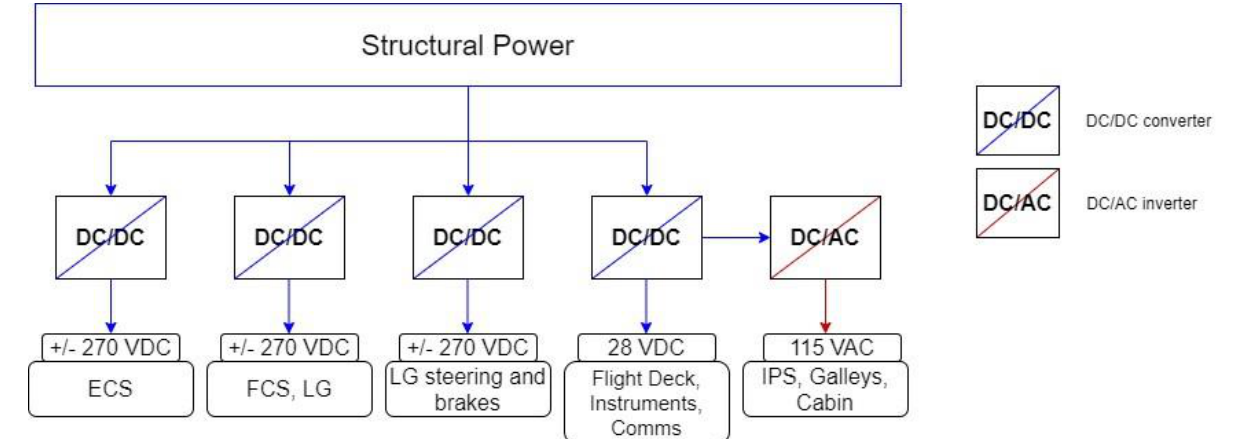
Figure A1. More-electric aircraft power distribution (adapted from [66]).